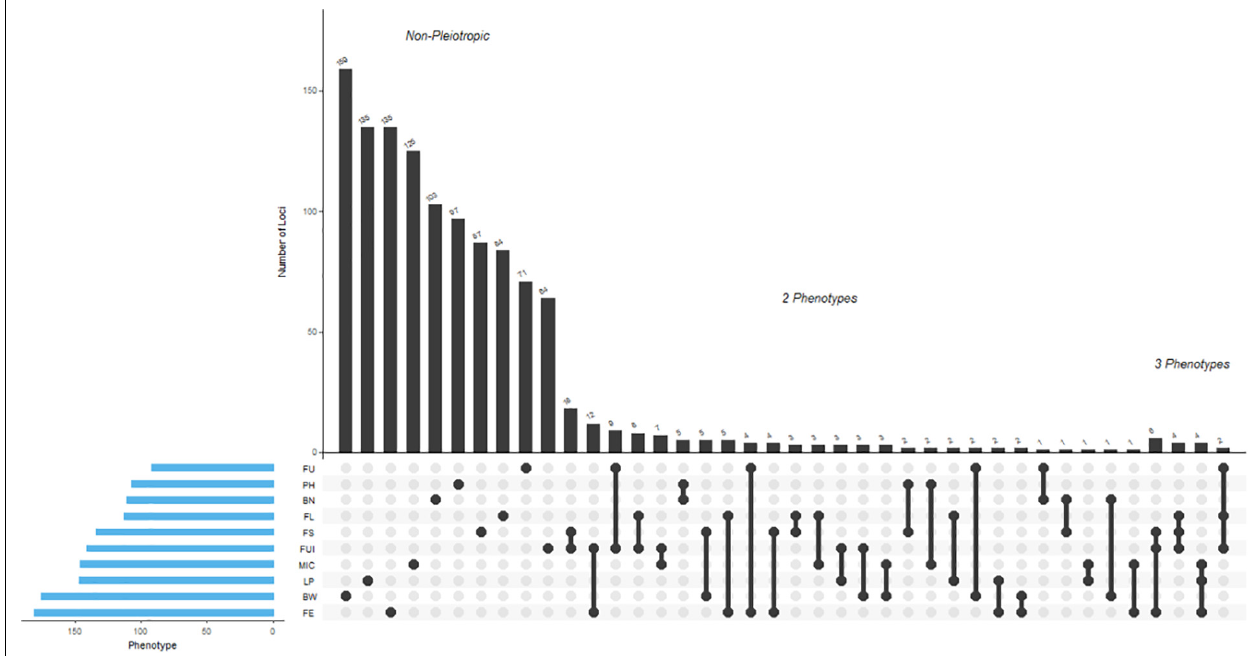
FIGURE 7 | Depicted here are results from the multivariate analysis of pleiotropy. For each associated SNP, the method returns the best-fitting solution of which phenotypes were associated with that SNP. All SNPs with one or more associated phenotypes are shown here. For example, every SNP associated with FE was found to be pleiotropic for other phenotypes. The total number of pleiotropic as well as unique associated SNPs for each trait from these analyses were 181 (FE), 176 (BW), 147 (LP), 146 (MIC), 141 (FUI), 134 (FS), 113 (FL), 111 (BN), 107 (PH), and 92 (FU).